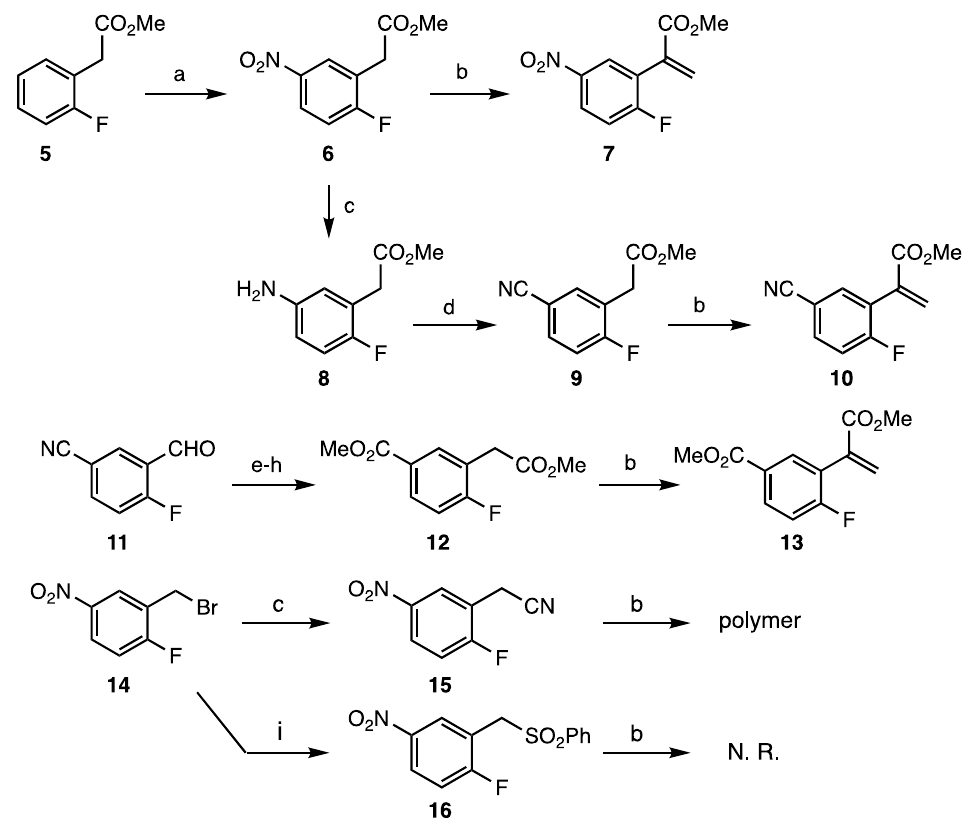
Scheme 1. Synthesis of the reaction substrates to prepare methyl 1-alkyl-1 H